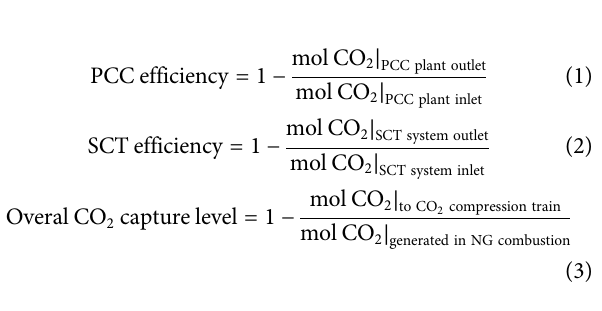
Frontiers in Energy Research |